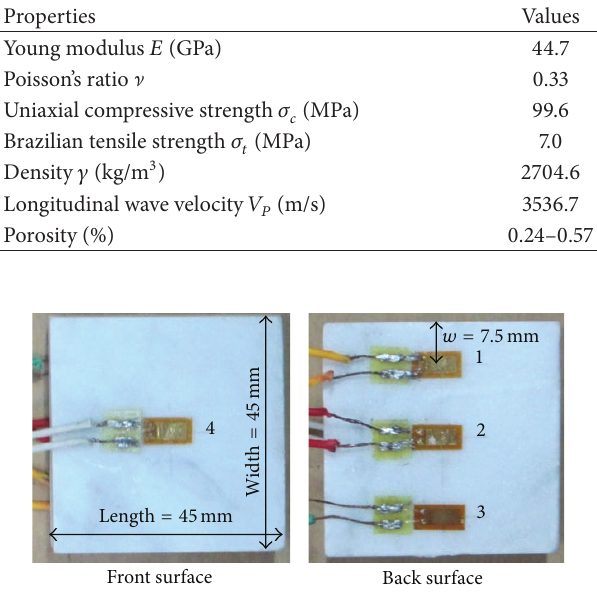
Figure 1: The layout of strain gauges on prismatic marble specimen (impact loading direction: from right to